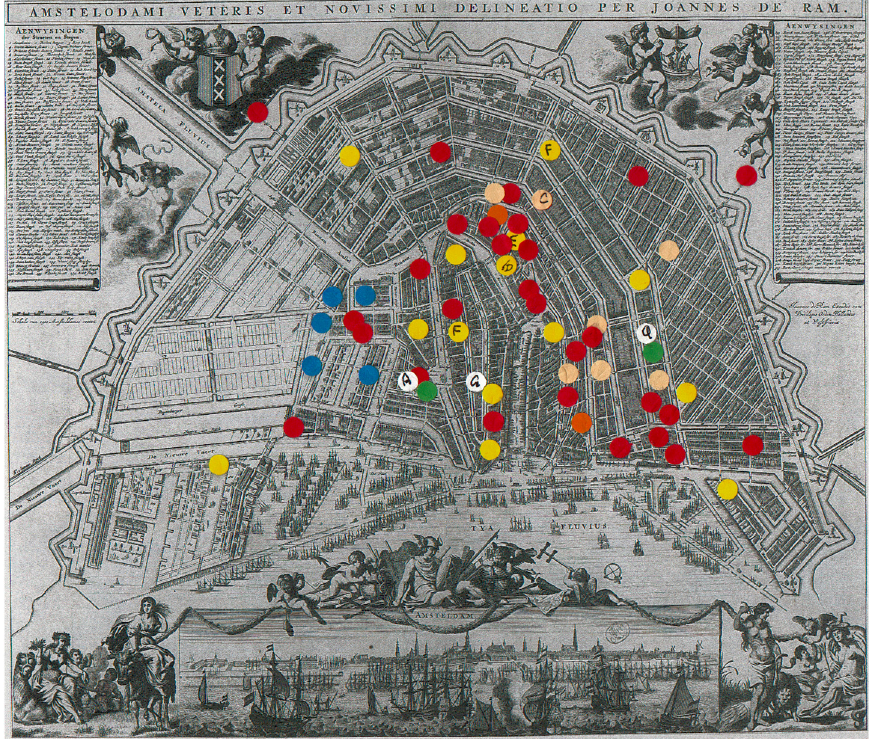
Figure 1. Map of Amsterdam, designed by Johannes de Ram, ca. 1683, Rijksmuseum Amsterdam sign. RP-P-AO-20-46, overlaid with an impression of the locations of churches and synagogues. What strikes the eye is that the Reformed Church, as the result of an extensive building programme, had the use of old and new church buildings evenly spread throughout the old city centre as well as the recently built neighbourhoods around it: the yellow dots. Reformed immigrants from Francophone, Anglophone or German speaking lands could attend services in their own designated buildings (yellow dots marked F, E, D respectively). Yet the Reformed churches were far outnumbered by the Catholic ‘hidden churches’: the red dots. Various other religious groups were numerous enough to have several places of worship at their disposal: the relatively prosperous Mennonites (salmon dots) in the prestigious western half of the city, the on average poorer Jews (blue) at the